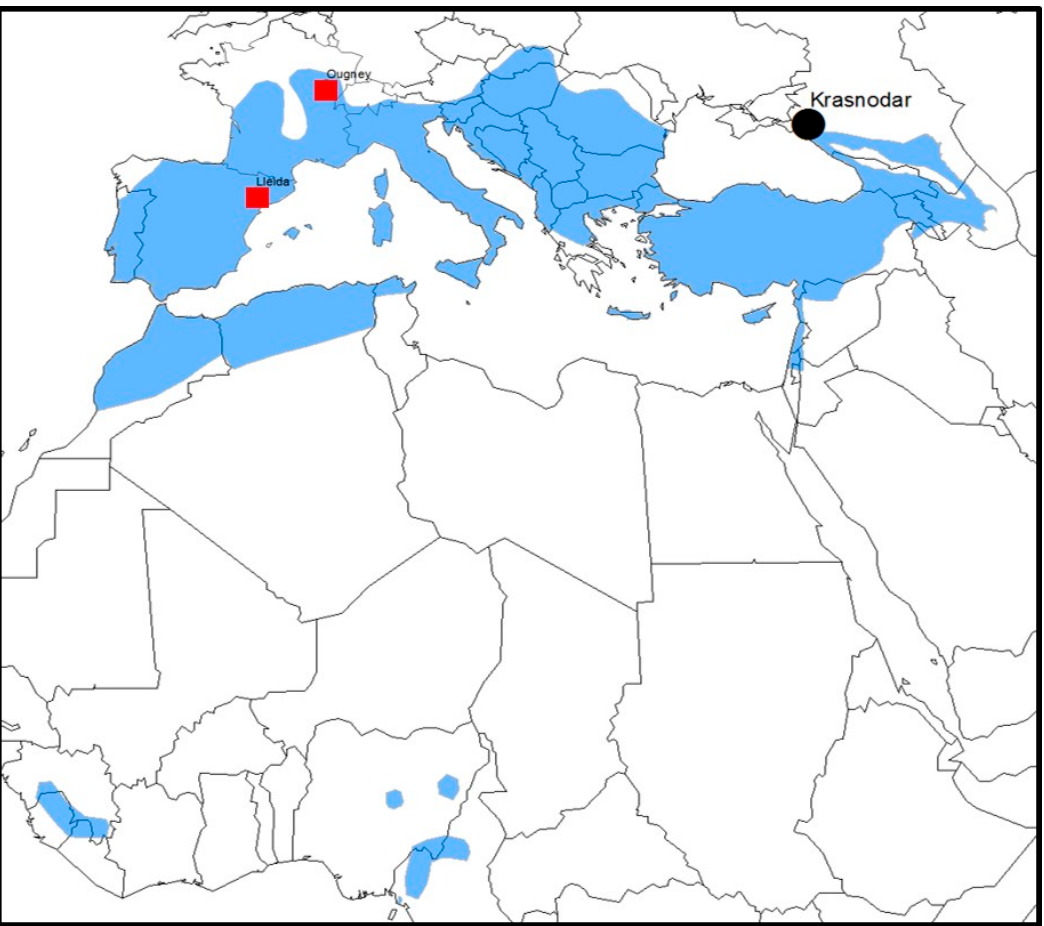
Figure 1. Location of Lleida Bat lyssavirus (LLEBV) cases (red squares) and West Caucasian Bat lyssavirus (WCBV) (black circle). Geographical distribution of Miniopterus schreibersii (blue shadow). Host range data derived from IUCN (www.IUCN.org).